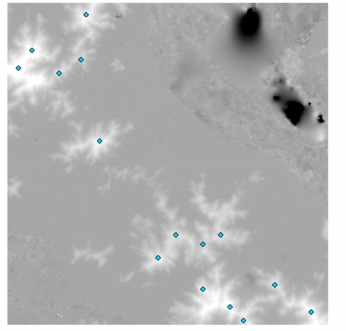
Figure 33. The distribution map of the seventh dataset extracted using the reference